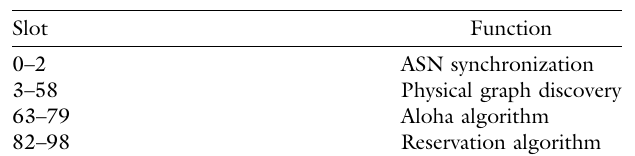
Table 2. Superframe